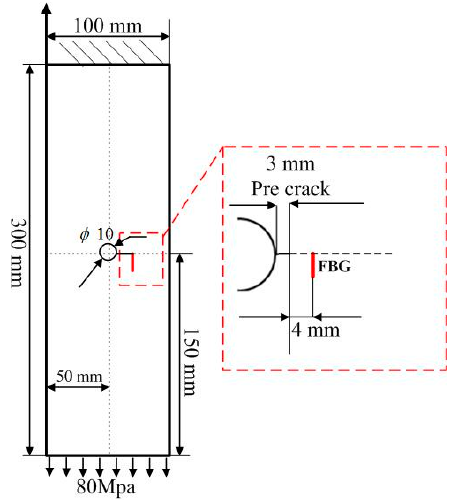
Figure 1. Schematic of the aluminum specimen.